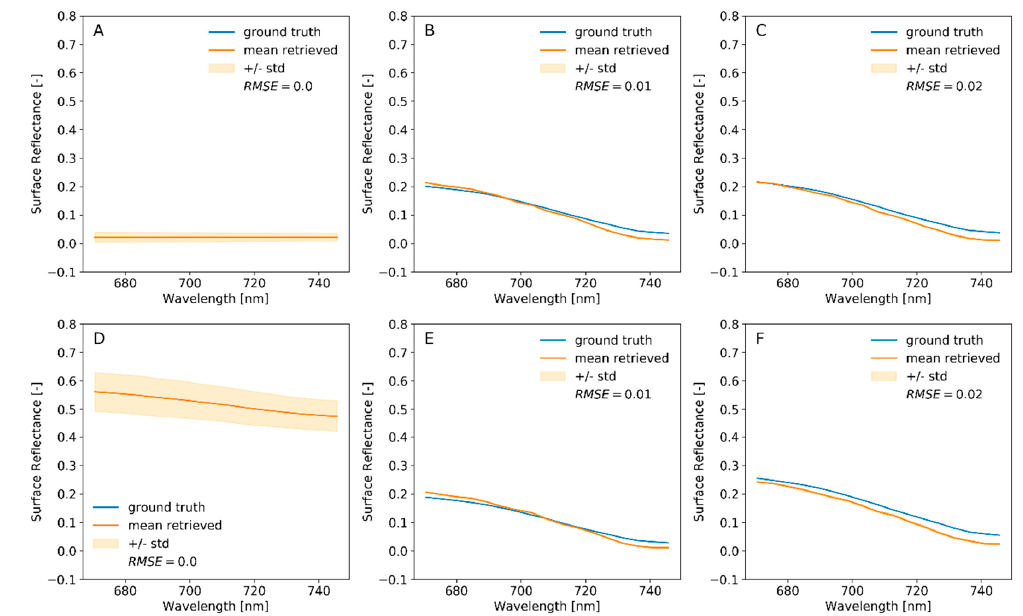
Figure 8. Comparison between empirical line calibration and field spectra for the dark ( A ) and bright ( D ) targets and four melt pond buffers ( B , C , E , F ). RMSE is computed for bands between 670 nm and 750 nm.